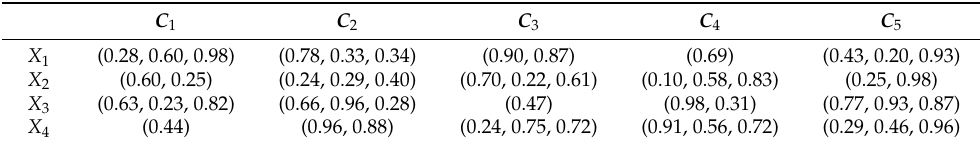
Table 2. Hesitation Fuzzy Decision Matrix of Suppliers.